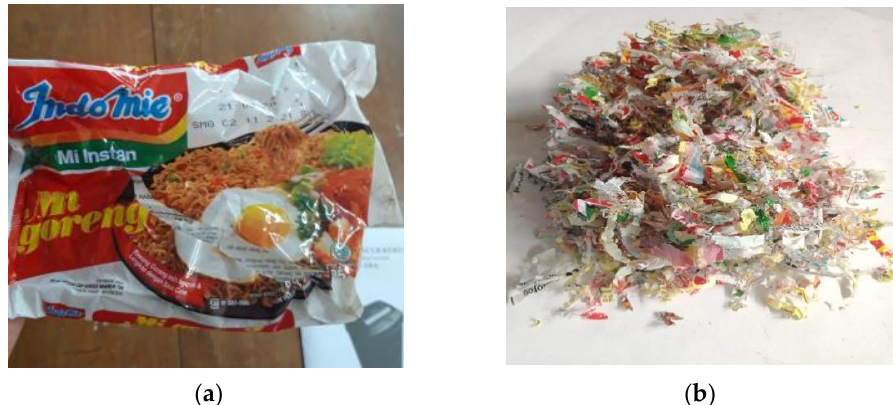
Figure 1. ( a ) Instant noodle food packaging. ( b ) Small pieces of instant noodle food packaging after shredding process.